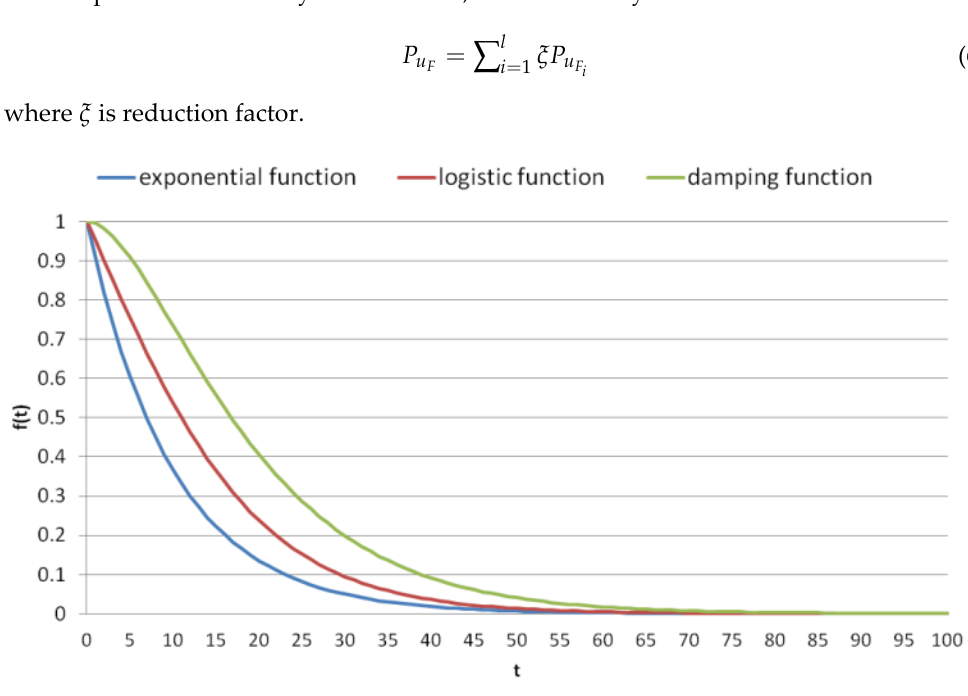
Figure 6. Diagrams of three time functions.